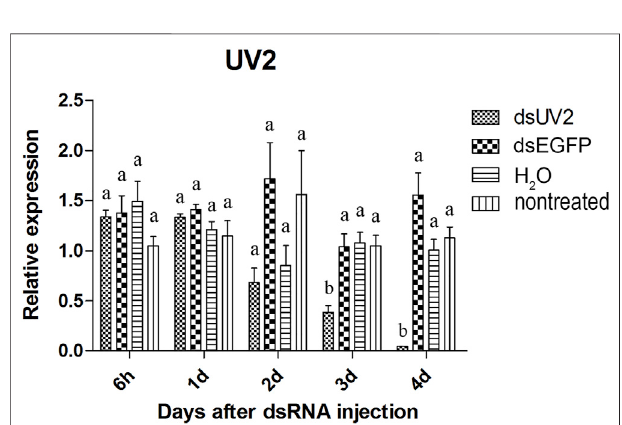
FIGURE 5 | Relative expression UV opsin 2 in EAB adults after dsRNA injection. Relative expression of UV opsin 2 byRT-qPCR assaywasevaluated 6 hours, 1, 2, 3 and 4 days after injecting 3 µg dsRNA. TEF-1 α was used as a reference gene for normalization. Means ± SE (n = 4) are shown. letters between different treatments at the same time